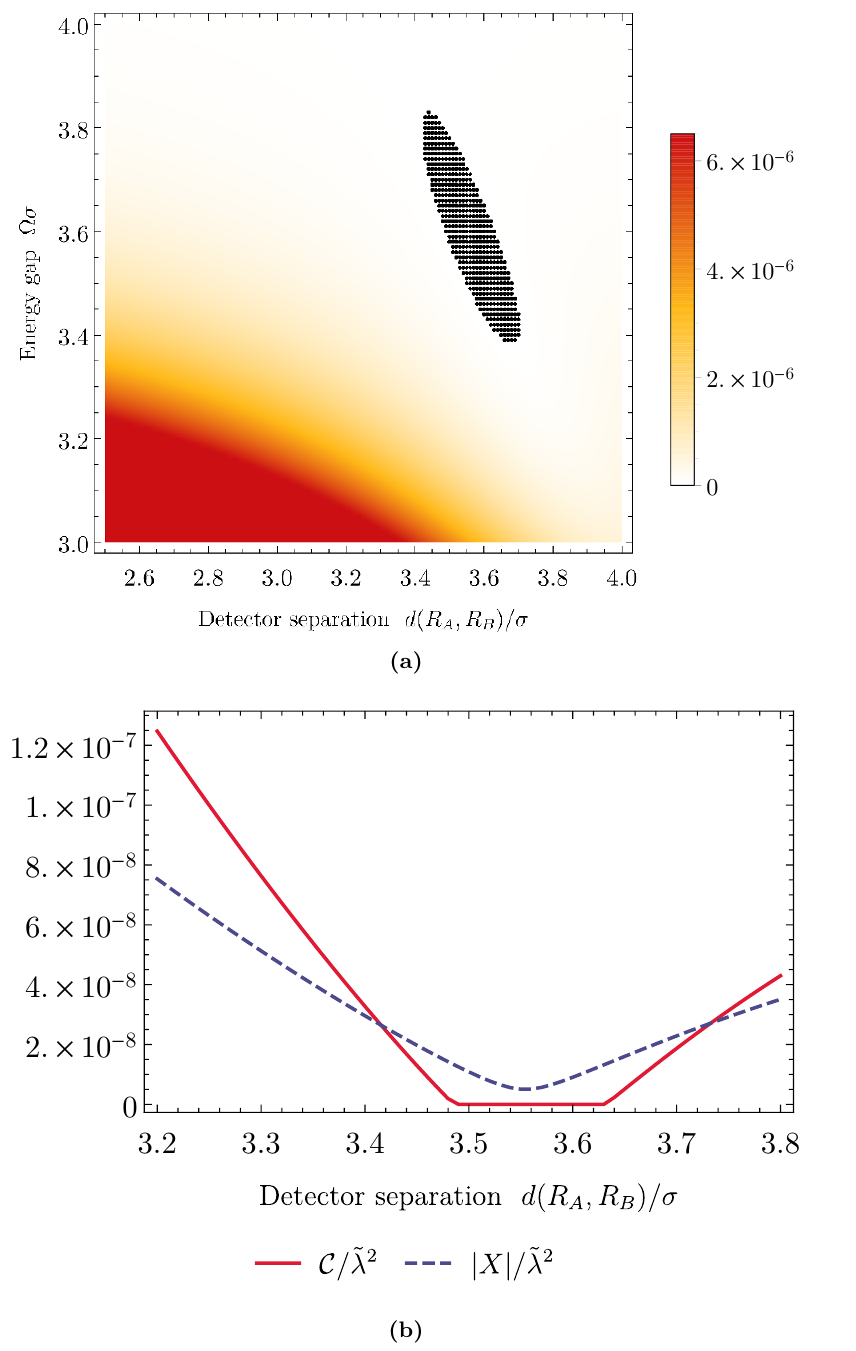
Figure 8 . For Dirichlet boundary conditions ( (cid:16) = 1) and an AdS length of ‘=(cid:27) = 5 = 2, plot (a) depicts a close-up of the separability island in the parameter space spanned by proper detector separation d ( R A ; R B ) =(cid:27) (with A at the origin) and energy gap (cid:10) (cid:27) in which no entanglement harvesting is possible; and in (b) the concurrence C = ~ (cid:21) 2 and the absolute value of the matrix element X are plotted as a function of the detectors proper separation d ( R A ; R B ) =(cid:27) for detectors with an energy gap of (cid:10) (cid:27) = 3 : 6. It is easy to see that the vanishing region of concurrence is located about the local minimum of j X j